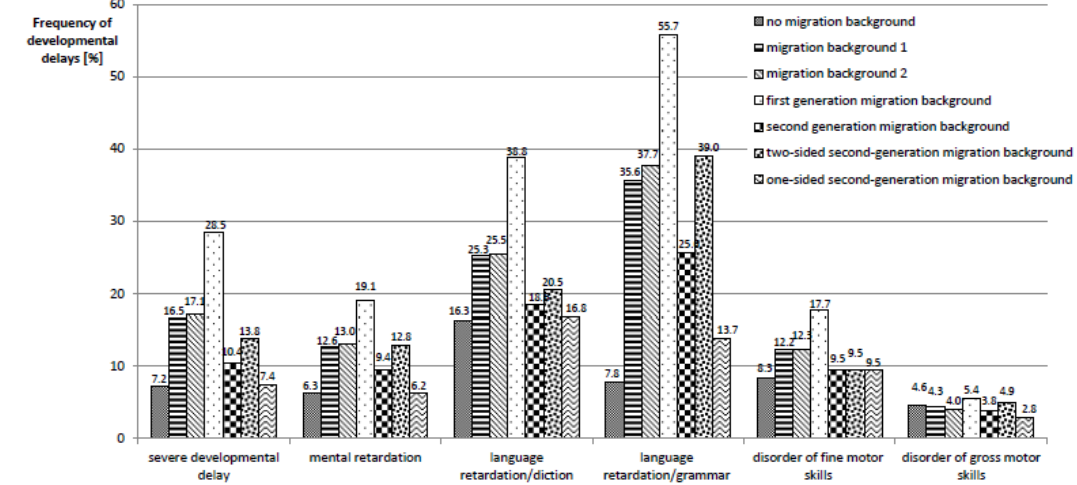
Figure 3. Frequencies of developmental delays, stratified according to migration status.